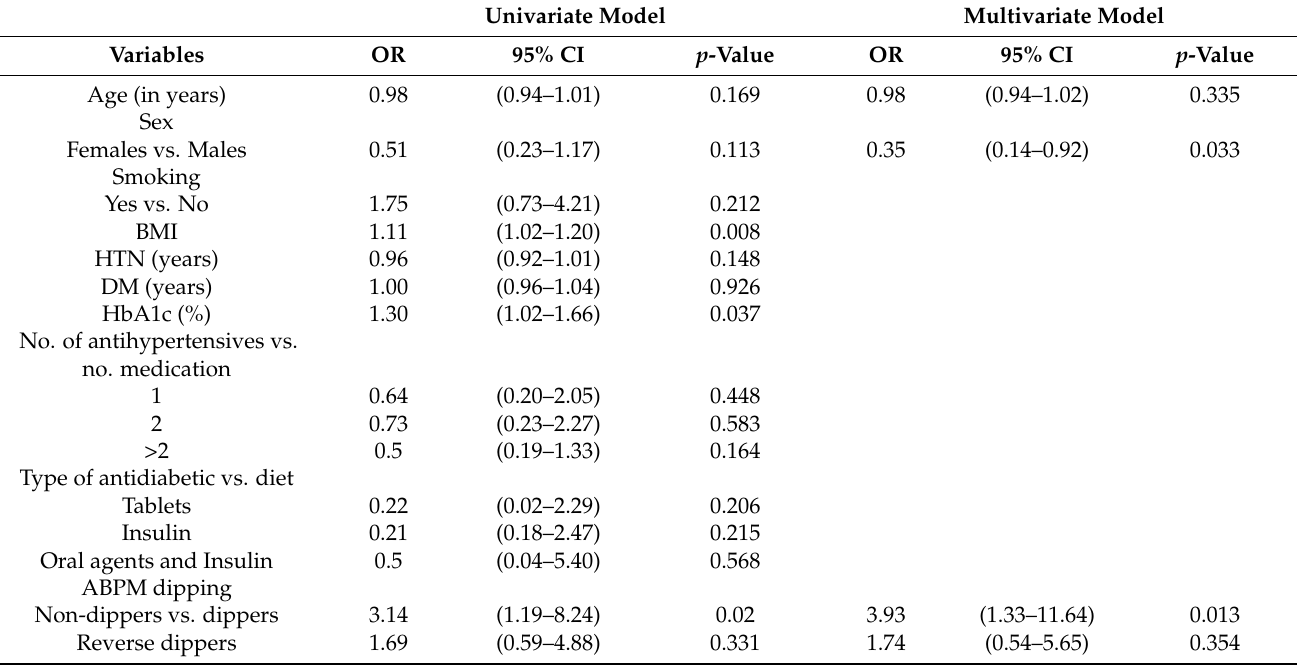
Table 4. Odds ratios (OR) and 95% confidence intervals (CI) for the association between stages of DPN and